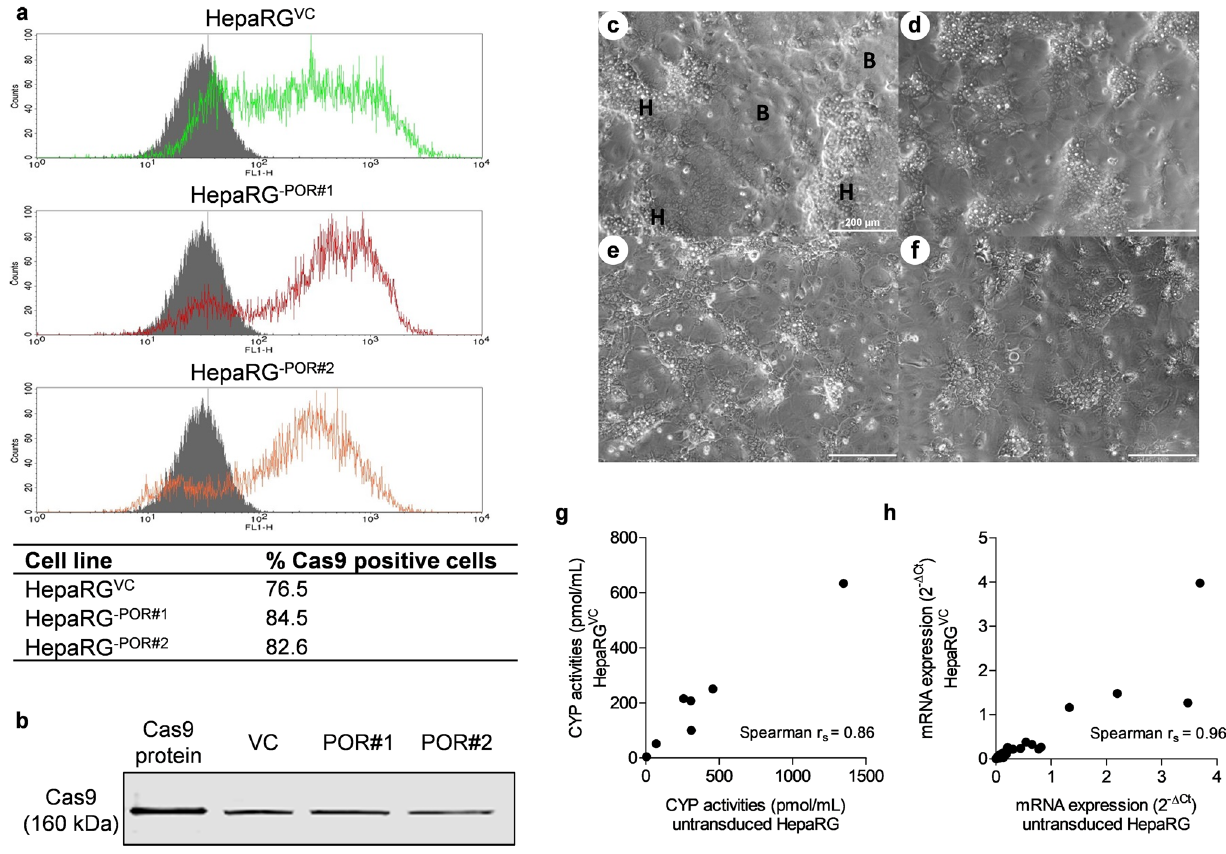
Figure 1. Cas9 Expression in transduced HepaRG cells. ( a ) Flow cytometry analysis of undifferentiated HepaRG VC (green), HepaRG –POR#1 (red) and HepaRG -POR#2 (orange) in comparison to untransduced HepaRG cells (grey) ( b ) Western blot analysis of Cas9 expression in lysates of undifferentiated HepaRG VC , HepaRG – POR#1 and HepaRG -POR#2 , Cas9 protein as positive control (see Supplementary Fig. S1 online for full blot). ( c-f ) Morphology of untransduced, differentiated HepaRG cells. H: hepatocyte-like cells; B: biliary-like cells ( c ) compared to differentiated HepaRG VC ( d ), HepaRG –POR#1 ( e ) and HepaRG -POR#2 ( f ). ( g ) Correlation of 7 CYP activities in transduced versus untransduced differentiated HepaRG cells. ( h ) Correlation of mRNA expression levels of 72 genes in transduced versus untransduced differentiated HepaRG